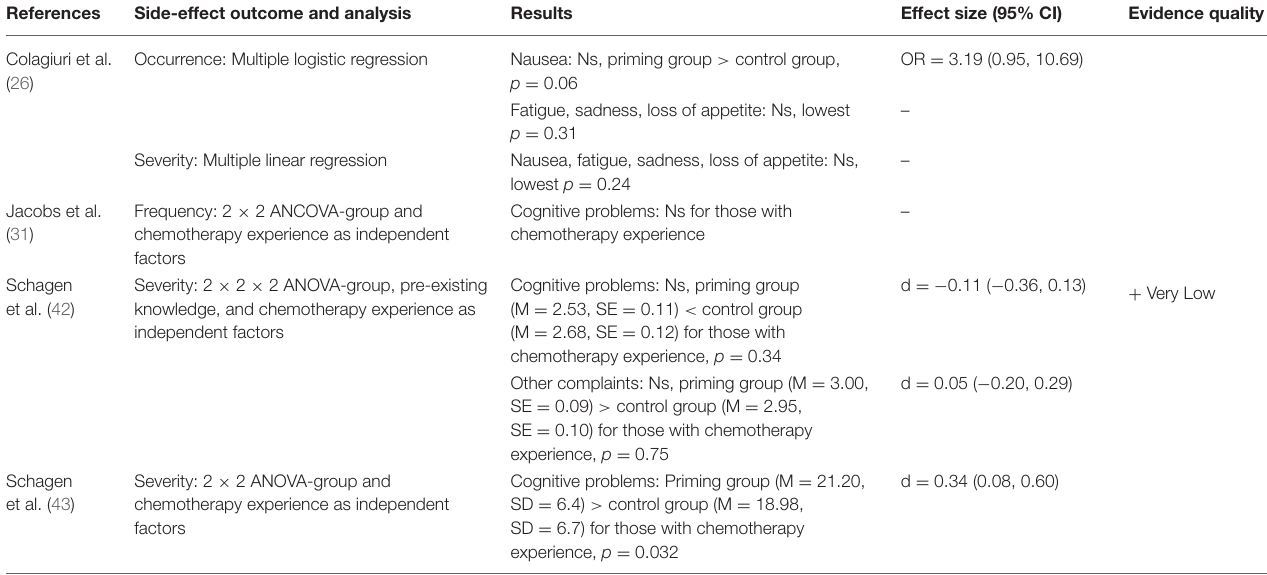
TABLE 2 | Priming intervention results.